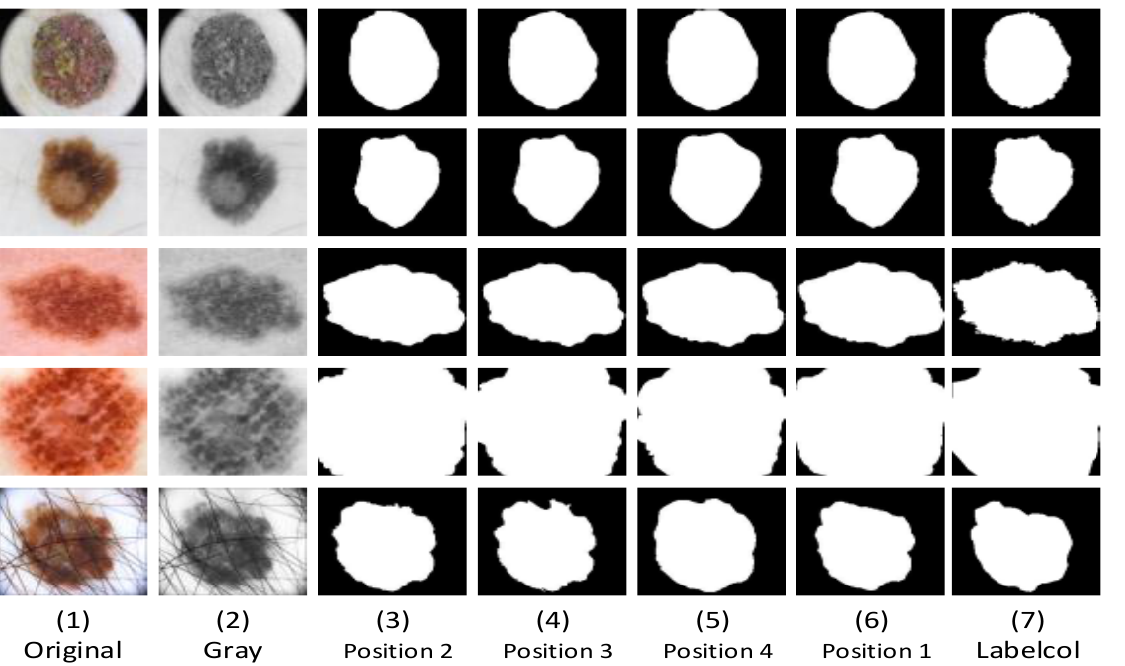
Figure 8. A visual comparison of each network in the ablation experiment. ( 1 , 2 ) The original image and grayscale image that were fed into the network. ( 3 – 5 ) The CTrans module is connected with the TokMLP block at the second, third, and fourth positions. Their segmentation effect is slightly worse, and their segmentation prediction graph is slightly greater than the labelcol graph. Compared with Figure 6, the segmentation performance is not ideal, and Figure 6 is closer to the label-column diagram. By comparing ( 3 , 7 ), Figure 6 is closer to the label diagram. By comparison ( 3 – 7 ), we can clearly see that the segmentation prediction graph is slowly approaching the label graph. By comparison, we can find that the position-one connection method can not only overcome the shortcoming of the CNN’s difficulty in capturing context connection but also achieve accurate segmentation of focal local